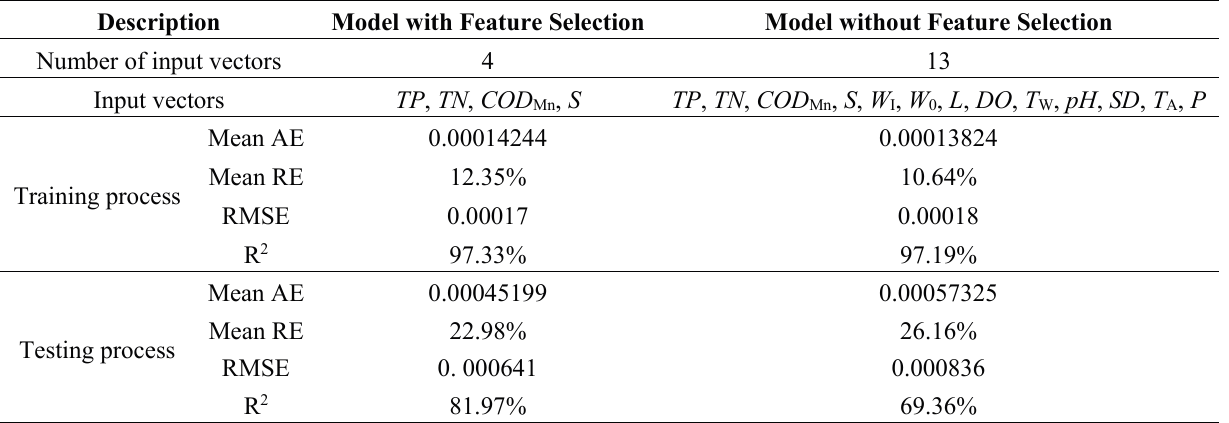
Table 1. Comparisons of model with feature selection and model without feature